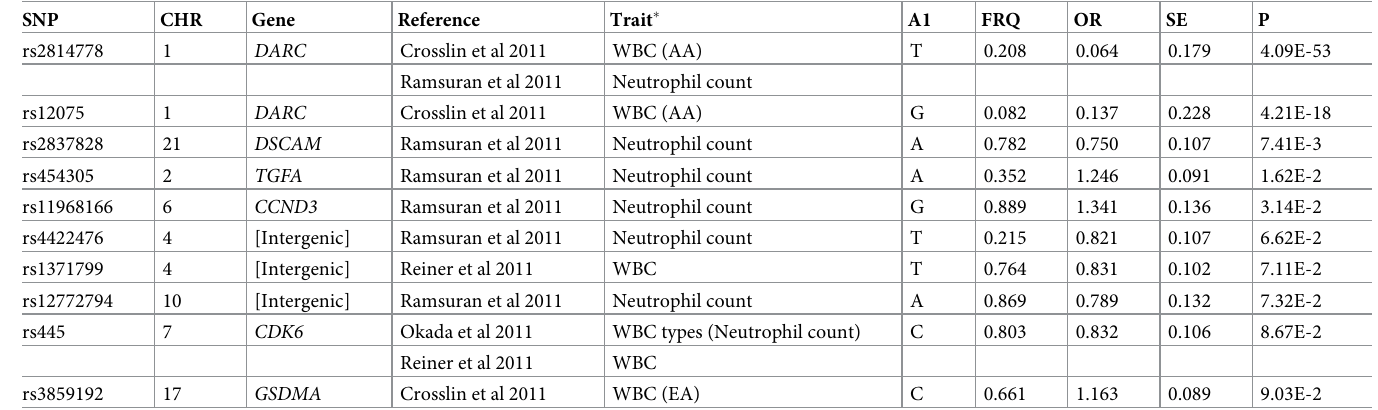
Table 2. In silico replication of previously reported GWAS-significant WBC-related